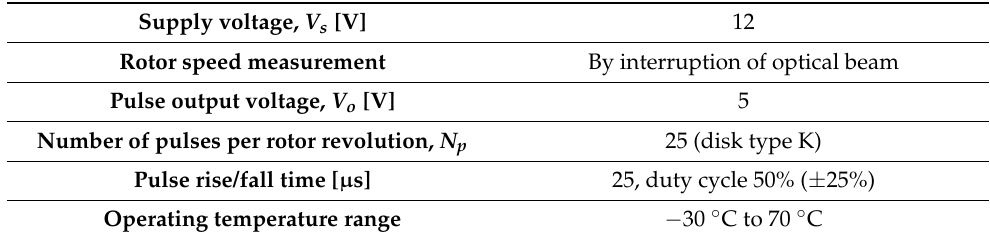
Table 2. Characteristics of the anemometer used for the TASEC ‐ Lab mission.